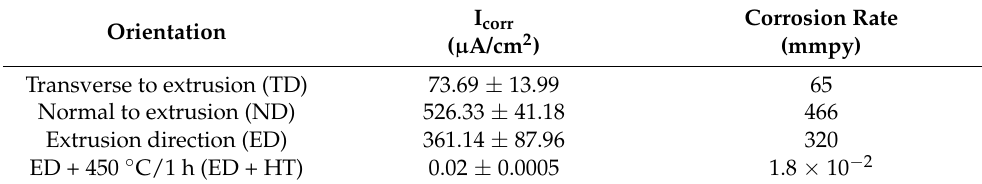
Figure 4. Potentiodynamic polarisation behaviour of the extruded ZK60 alloy in different planes with respect to the extrusion direction (i.e., ED, ND and TD) in 3.5 wt% NaCl. Table 2. Icorr and corrosion rate data (extracted from the PDP curves in Figure 3) in TD, ND and ED planes of the extruded alloy ZK60.